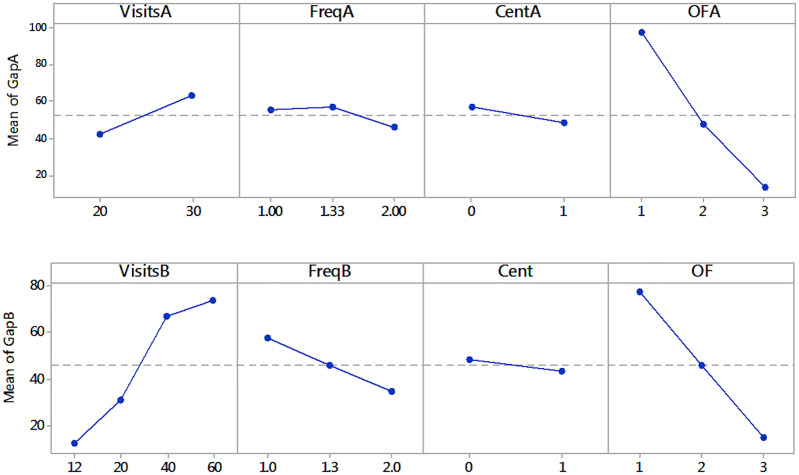
Main effects plots for gap (fitted means).Groups A and B, respectively.